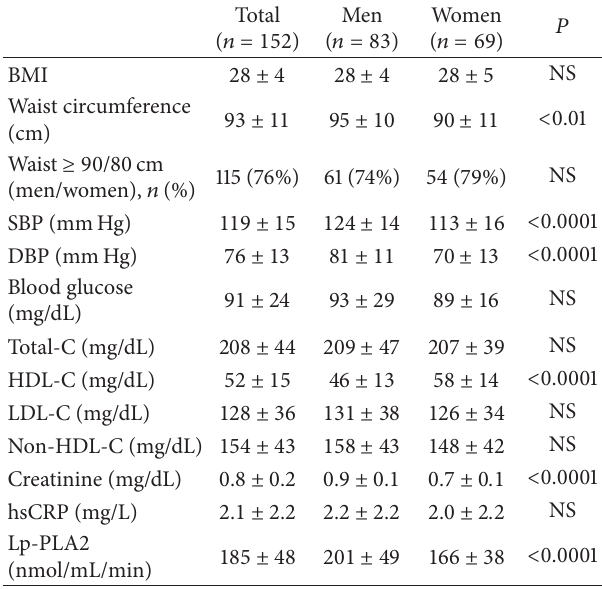
Table 2: Anthropometric measurements and laboratory data for all subjects divided by